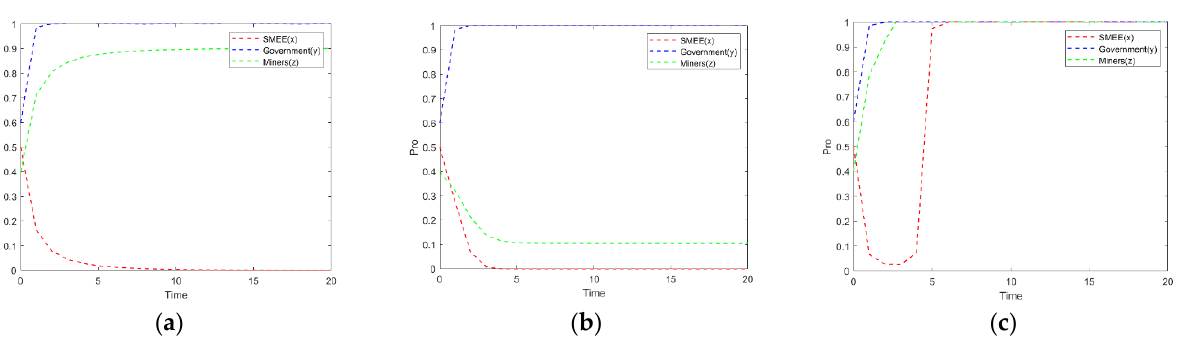
Figure 6. C b = 0.6, strategy evolution process of the three game subjects under 3 emotional states of the miner. ( a ) r 1 = r 2 = r 3 = 1; ( b ) r 3 < 1, r 1 = r 2 = 1; ( c ) r 3 > 1, r 1 = r 2 = 1.